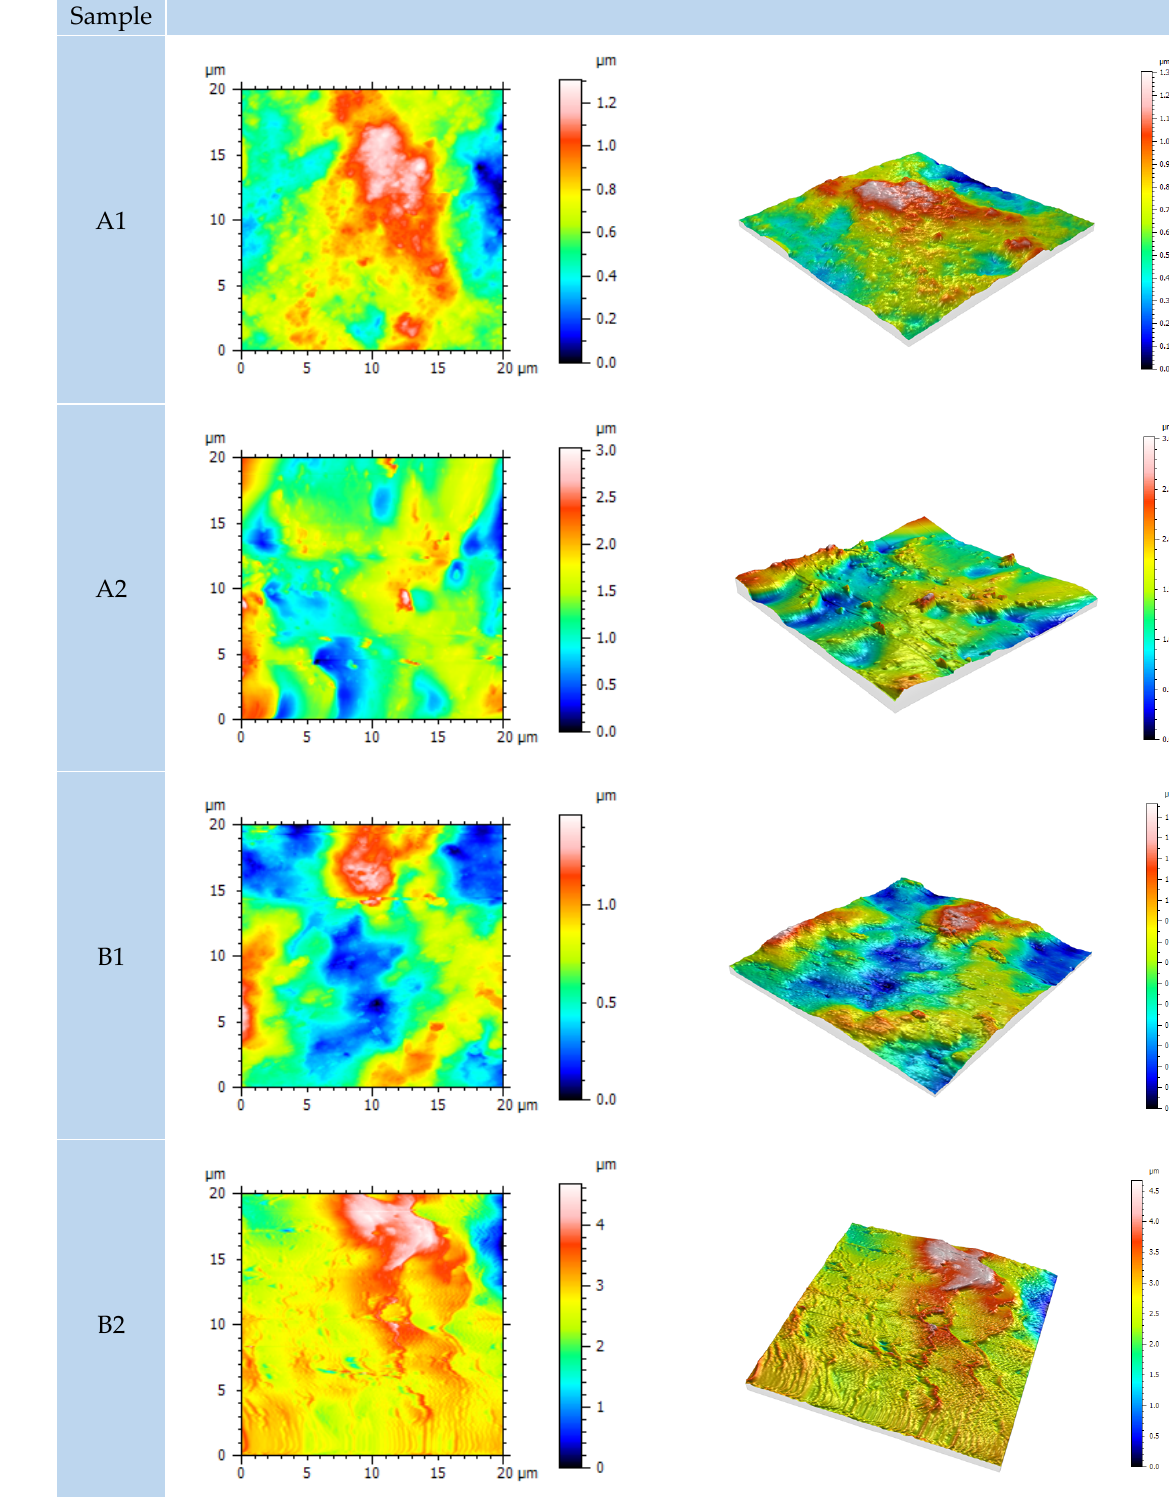
Figure 14. AFM surface topography of differently dried coated samples. Table 2 describes which coating layers are present in samples A1, A2, B1,